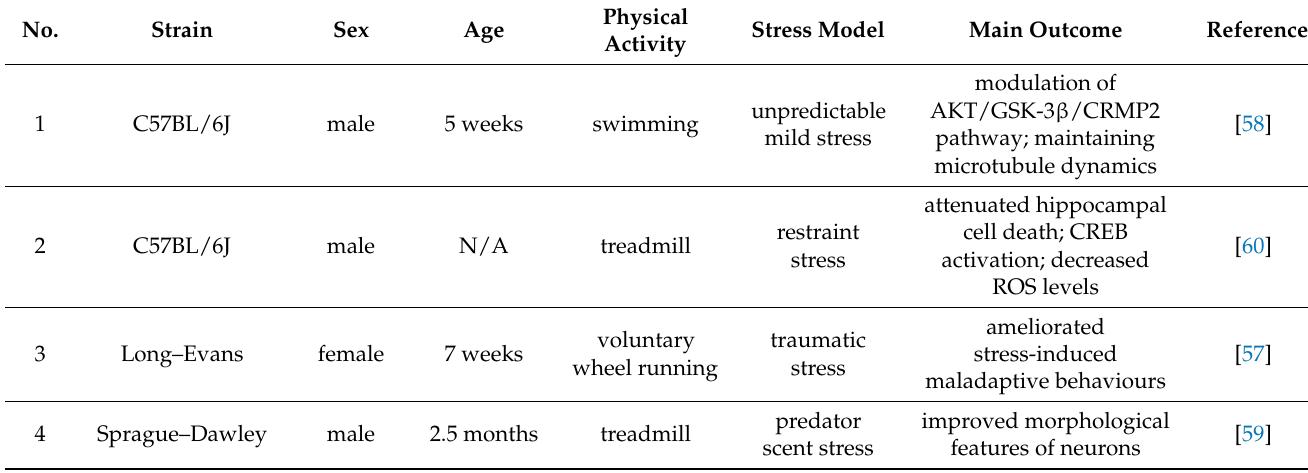
Table 1. Summary of animal research focusing on neurogenesis, neuroplasticity, and